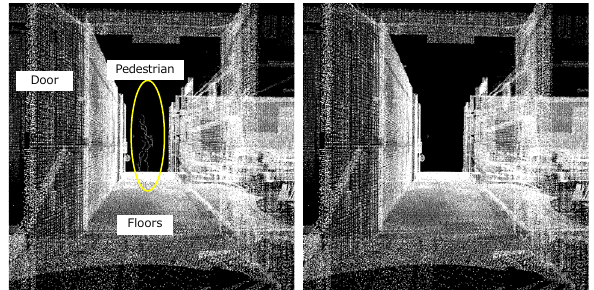
Figure 9. Pedestrian noise deletion (left: input point clouds, right: noise deletion result)